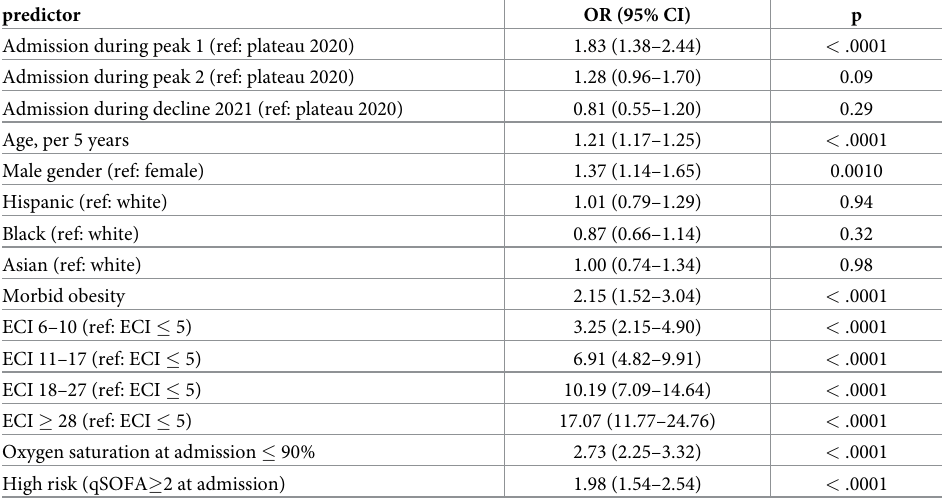
Table 4. Independent predictors of inpatient mortality in patients with COVID-19 across the entire study period. predictor OR (95% CI)